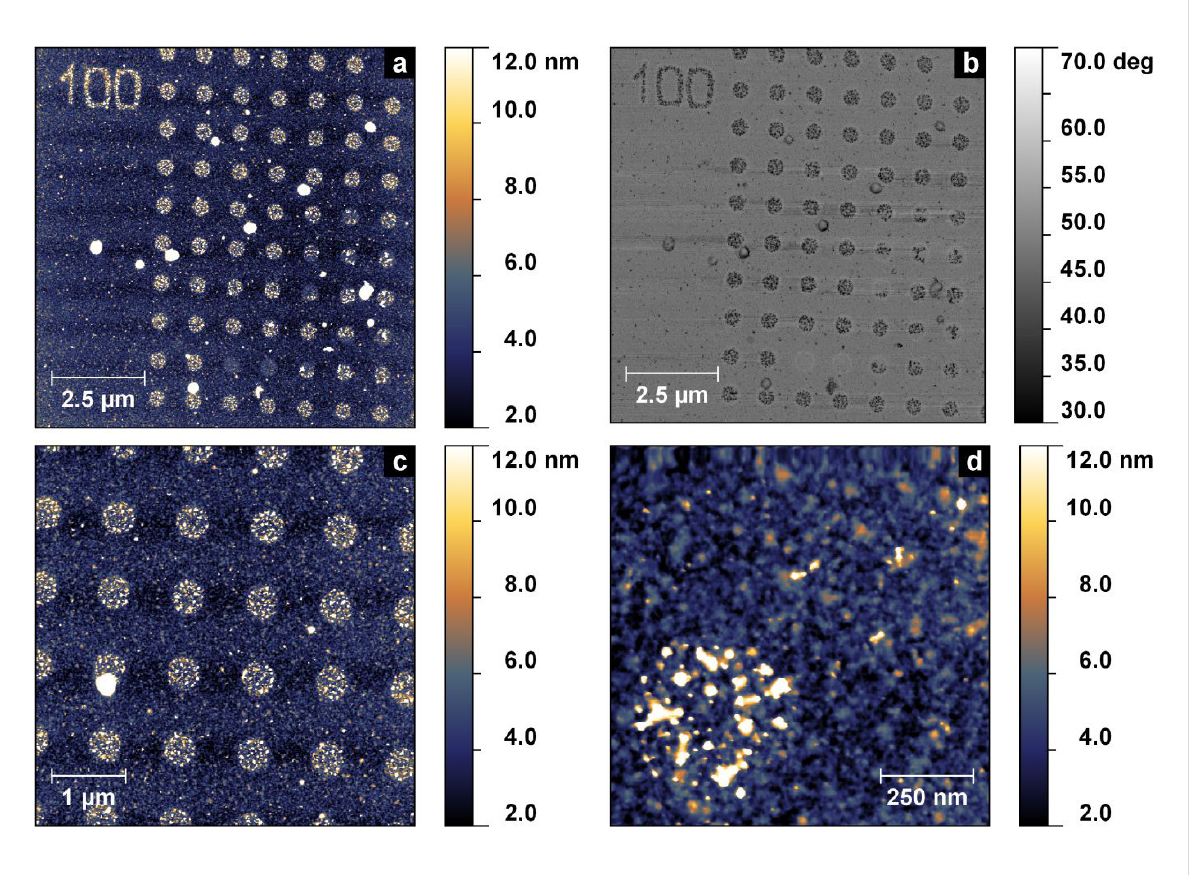
Figure 4: Height (a,c,d) and phase (b) measurements via AFM of an irradiated CSPETCS monolayer incubated with 6 nm AuNP.